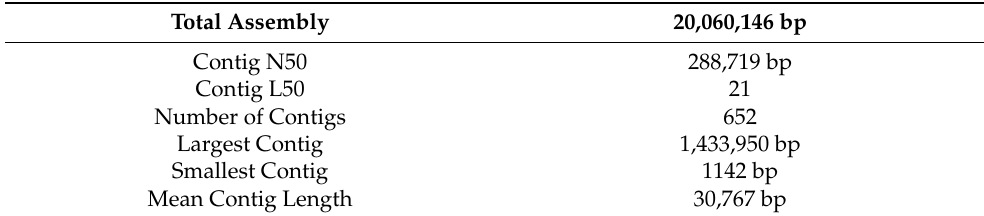
Table 1. Summary metrics of assembled flow-sorted alpaca Y material from the combined PacBio and Illumina data. Total Assembly 20,060,146 bp Contig N50 288,719 bp Contig L50 21 Number of Contigs 652 Largest Contig 1,433,950 bp Smallest Contig 1142 bp Mean Contig Length 30,767